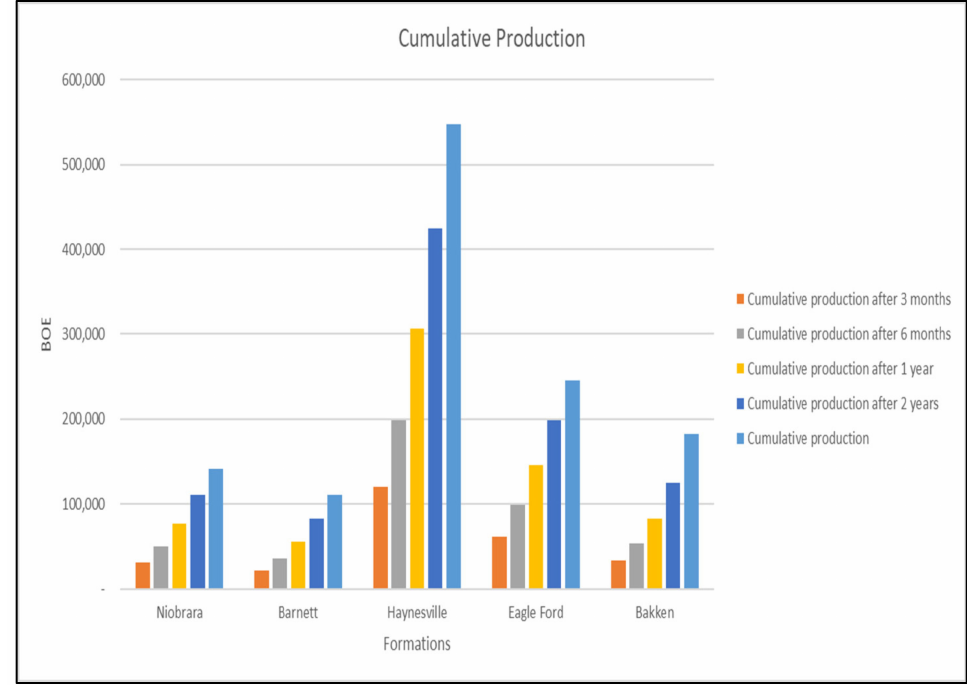
Figure 2. Average cumulative production volumes after entire well’s life, two years, one year, six months, and three months for all wells from each formation. BOE: barrel of oil